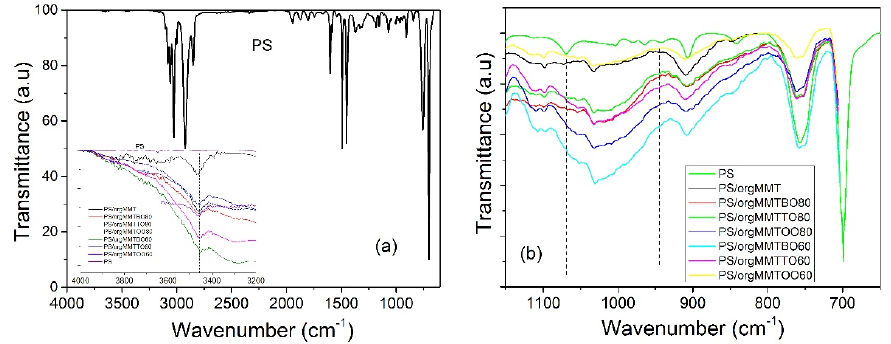
Figure 3. FTIR spectra of neat PS (a) and PS/orgMMTEO nanocomposites in the wavenumber range 4000-3200 cm -1 (a) and 1150-650 cm -1 (b).